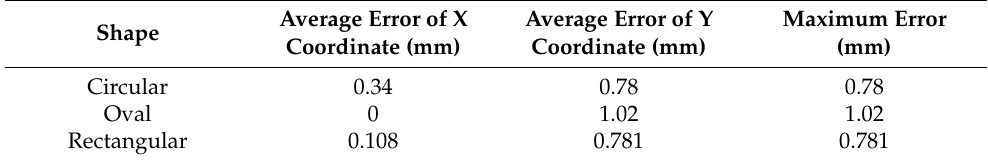
Table 2. Maximum average error for center